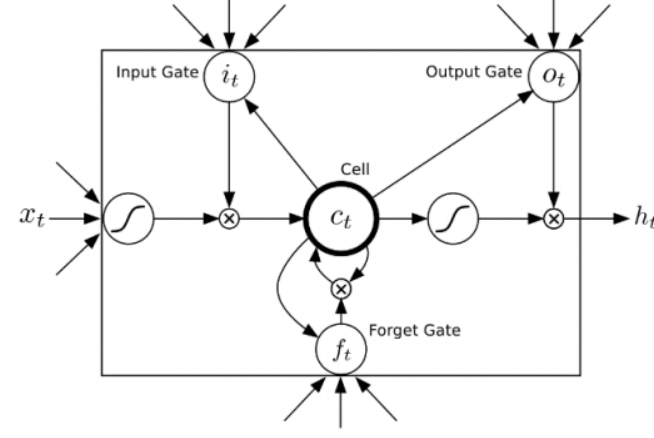
Figure 2. Long Short—Term Memory Neural Network [26].